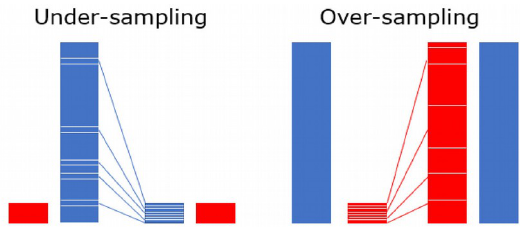
Figure 3. Under-sampling and over-sampling